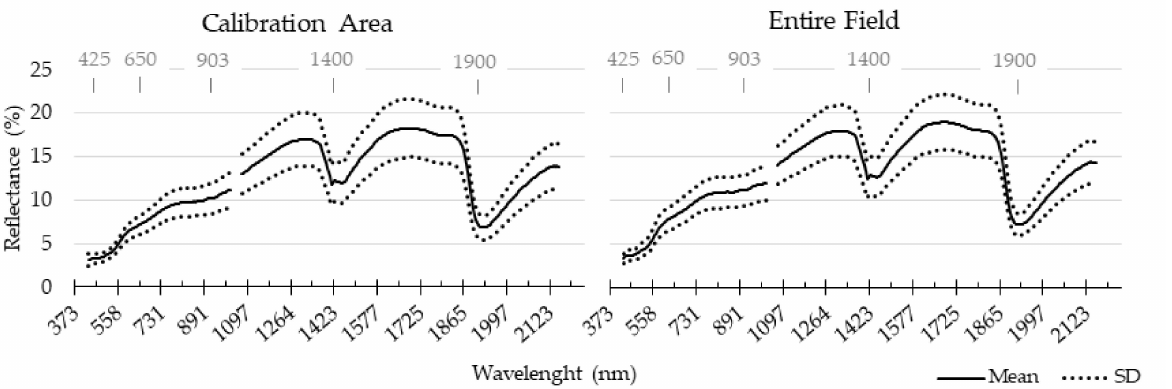
Figure 4. Mean and standard deviation (SD) of visible and near-infrared (vis–NIR) spectra acquired through the on-line survey performed in both the calibration area (spectral data acquisition 1) and the entire field (spectral data acquisition